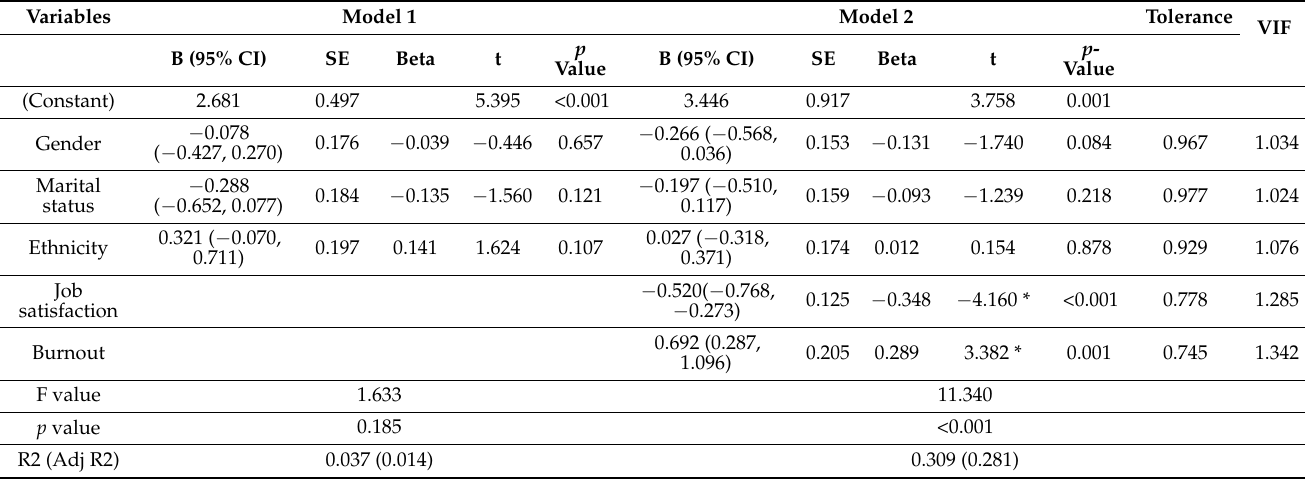
Table 7. Results of Hierarchical Regression Analysis for Intention to